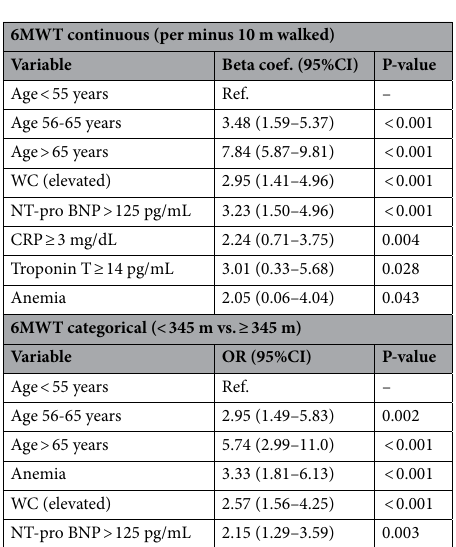
Table 1. Baseline characteristics of the patients by tertiles of 6MWT. 6MWT, 6-minute walking test; BMI, body mass index; WC, waist circumference ≥ 102 cm in men and ≥ 88 cm in women; MI, myocardial infarction; AFib, atrial fibrillation; SBP, systolic blood pressure; DBP, diastolic blood pressure; LVEF, left ventricular ejection fraction; a echocardiographic alterations defined by a left atrial volume indexed > 34 ml/m 2 or left ventricular hypertrophy or E/e’ > 13 or septal or lateral e’ > 9; RA, rheumatoid arthritis; DAS28 with ESR, disease activity score 28 with erythrocyte sedimentation rate; AID, autoimmune disease; eGFR, estimated glomerular filtration rate; NT-pro BNP, N-terminal pro brain natriuretic peptide; CRP, C-reactive protein; ACEi or ARBs, angiotensin converting enzyme inhibitors or angiotensin receptor blockers; NSAID, non- steroidal anti-inflammatory drugs.